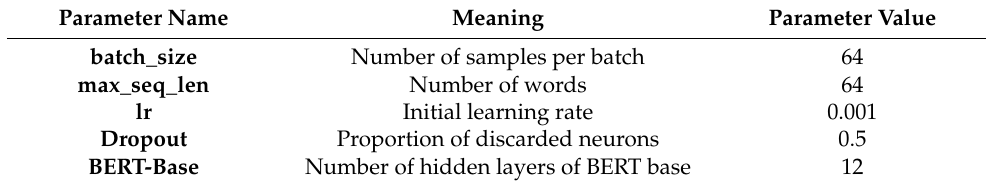
Table 6. BBiGRU-GA-CRF Model parameter setting.